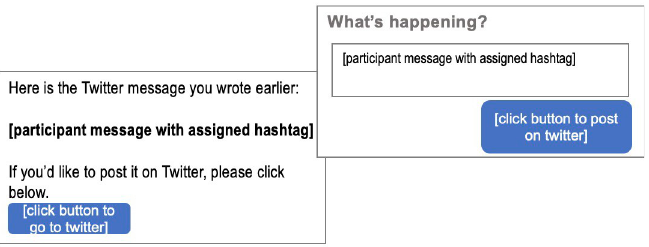
Fig 1. Images showing what participants saw as they proceeded to tweet their anti-litter messages.